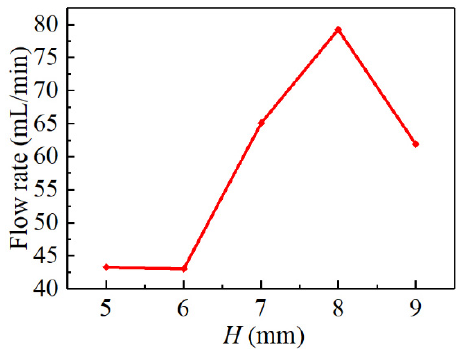
Figure 9. Corresponding maximum flow under different H.